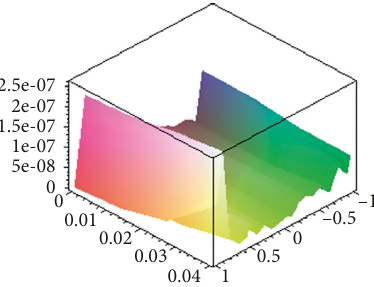
Figure 3: The error of the Hilbert kernel at time. T 0 . 3 (cid:27)